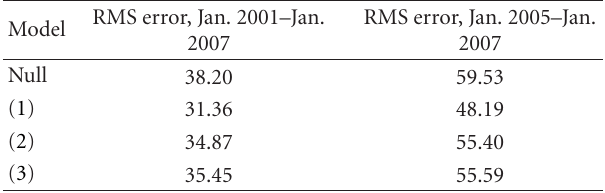
— — Table 2: Root-mean-square (RMS) errors in estimates of total daily burn area. “Null” model refers to a stationary Poisson model, where the expected burn area is constant. The second column shows the RMS of the residuals for each of the models, fitted and assessed using data from January 2001 to January 2007. The third column shows the RMS of the errors when each of the models is fitted using only data from January 2001 to December 2004, and then subsequently used to forecast burn area from January 2005 to January